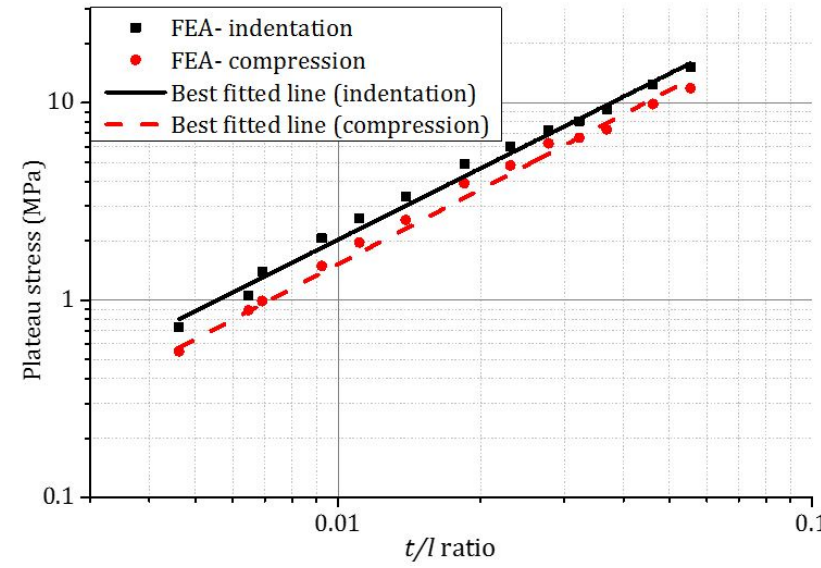
Figure 5. The effect of t/l ratio on the plateau stresses of honeycombs under compression and indentation loads at a strain rate of 1 × 10 3 s − 1 .